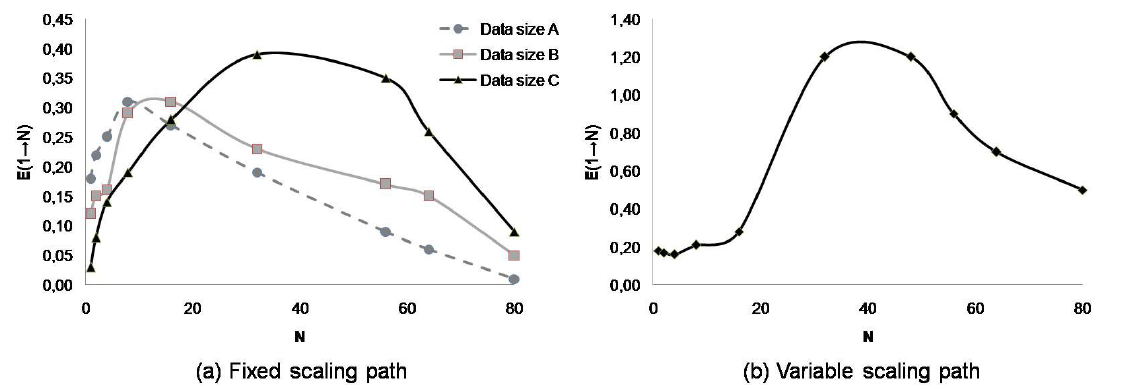
Figure 2: Montecarlo simulation service elasticity analysis with the two considered scaling paths